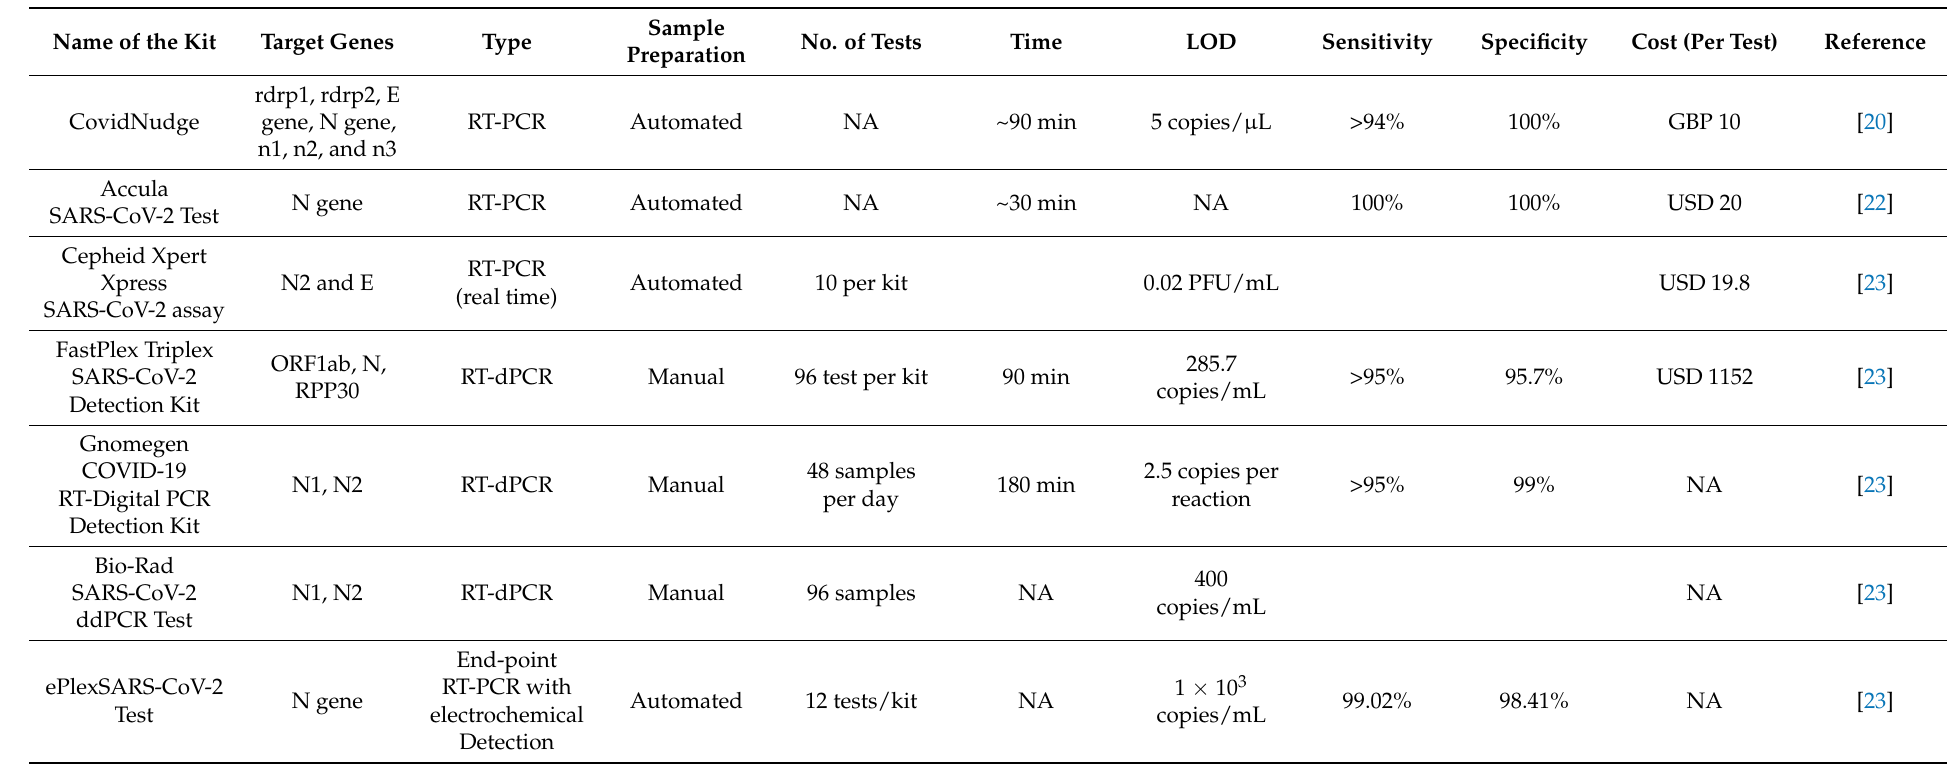
Table 1. List of commercial, automated RT-PCR systems authorized under emergency